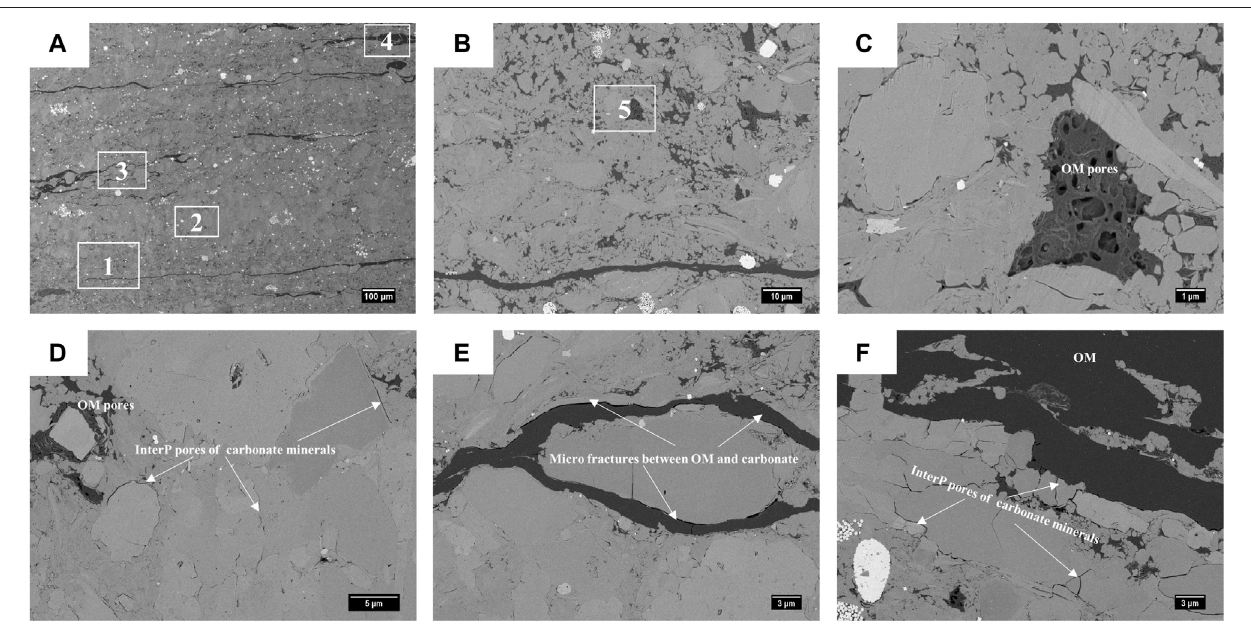
FIGURE5| SEMimagesofsampleWY23-6-6beforeWMinjection(mixedmudstone,laminationdevelopedwithorganicmatter(OM)pores,andinterparticlepores at the edge of carbonate particles). (B) An enlargement of rectangle area 1 marked in (A) , showing abundant OM. (C) An enlargement of rectangle area 5 marked in (B) , showing well-developed OM pores. (D) An enlargement of rectangle area 2 marked in (A) , showing well-developed interP pores in carbonate laminae. (E , F) An enlargement of rectangle areas 3 and 4 marked in (A) , showing microfractures at the edge of OM and interP pores around carbonate particles.